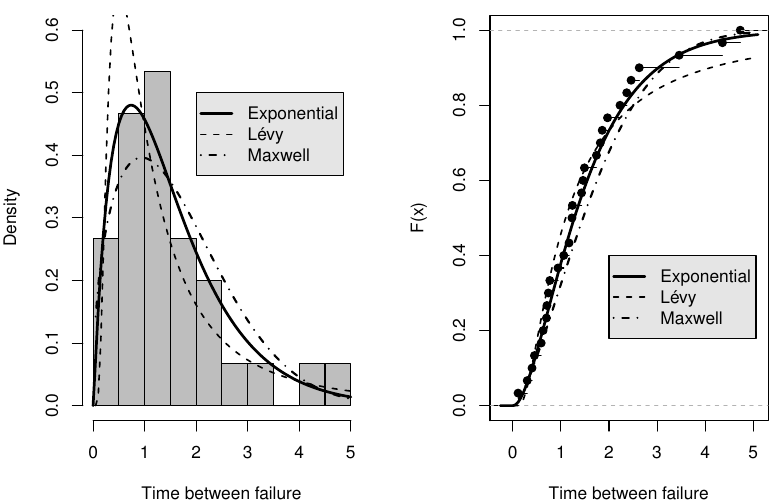
Figure 2. Estimated and empirical density and cdf of the selected baselines for repairable